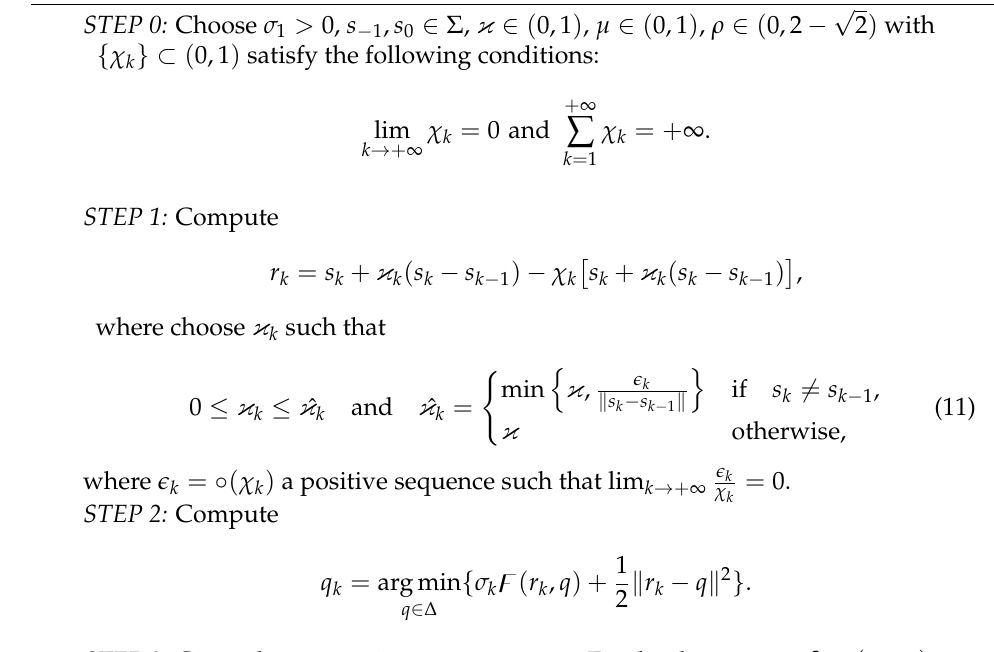
Algorithm 1: Explicit Subgradient Extragradient Method With Monotone Step- size